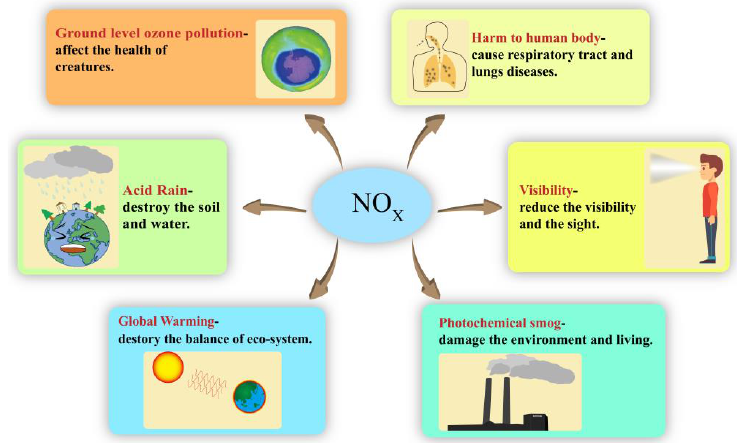
Figure 1. The environmental issues caused by NO x pollutants.